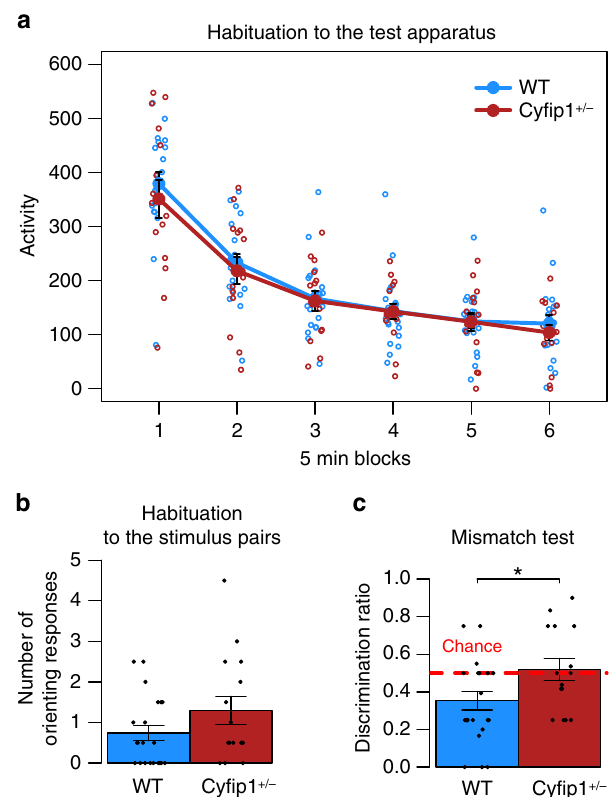
Fig. 6 Cy fi p1 haploinsuf fi cient rats show de fi cits in fl exible responses in orienting behaviour on a mismatch task. a There are no genotype effects on habituation to the experimental apparatus. Both WT ( n = 21) and Cy fi p1 + / − ( n = 15) show reduced activity to the experimental chambers over the course of each 30-min long session (5 min blocks). b Both WT and Cy fi p1 + / − rats showed reduced orienting to the auditory-visual sequences presented during training (ANOVA: F (1,34) = 2.4, p = 0.62), and c WT rats preferentially responded to the novel mismatched visual stimuli over the familiar matched stimuli (discrimination ratio <0.50). In contrast, Cy fi p1 + / − rats showed no preference, responding equally to both matched and mismatched visual cues (ANOVA: F (1,34) = 5.92,*). *<0.05,